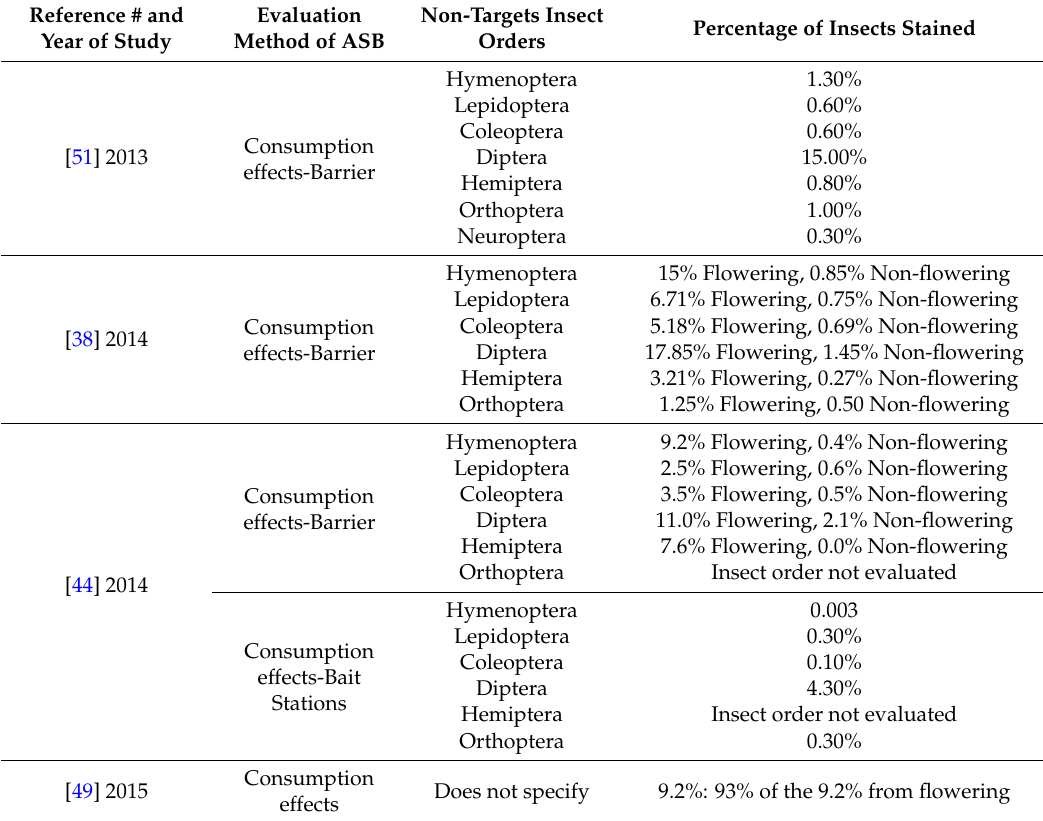
Table 4. Non-target studies conducted with commercially available attractive sugar bait (ASB) with insect orders and families evaluated for consumption effects of bait and secondary effects though consumption-affected